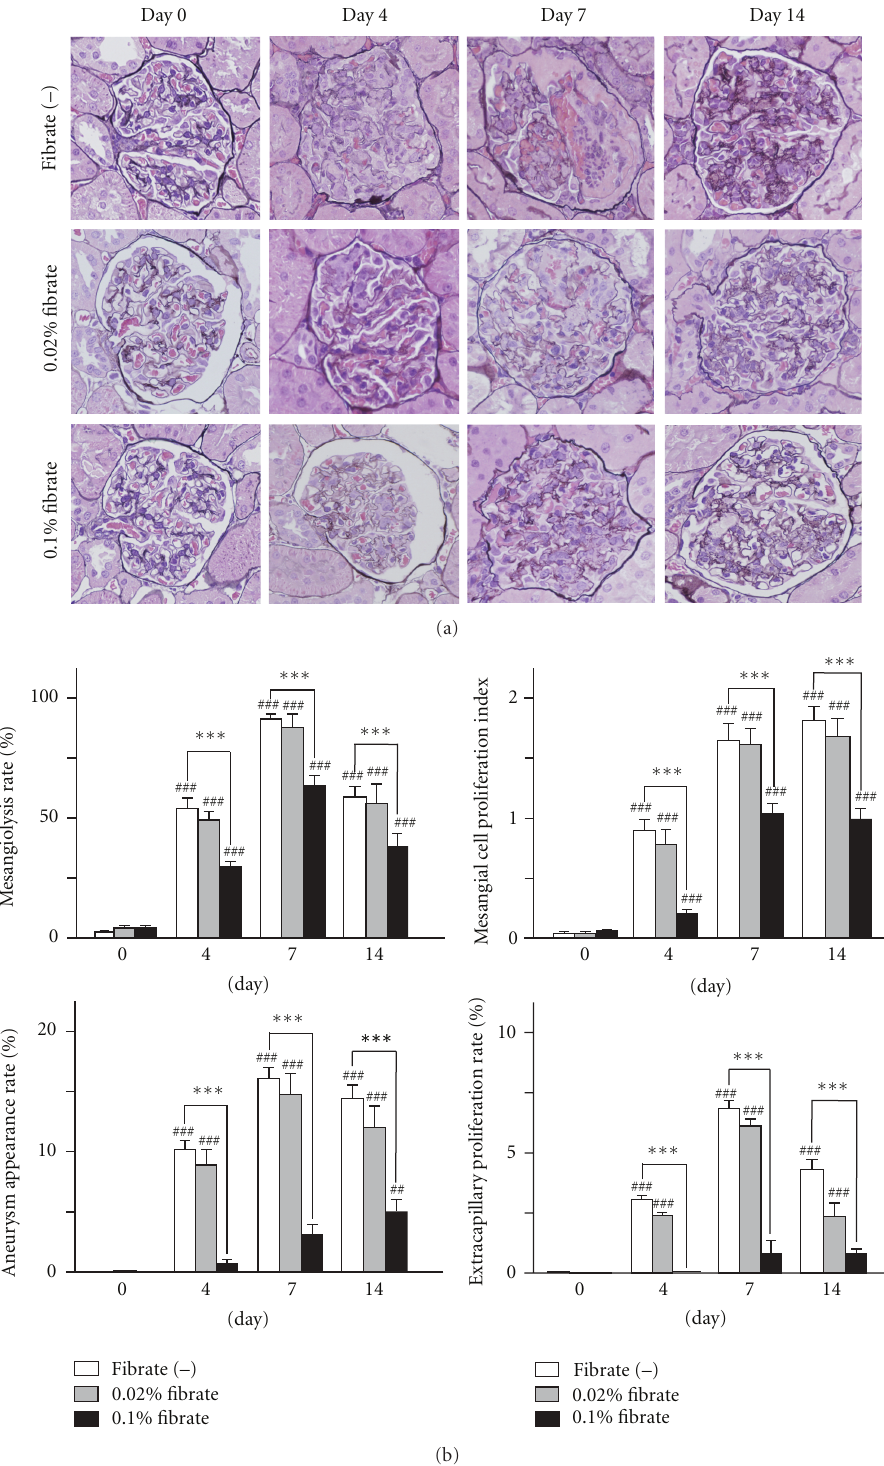
Figure 2: Light microscopic analyses of kidney injuries. (a) Representative micrographs of the kidney in anti-Thy1 nephritis rats. Kidney sections were stained with periodic acid methenamine silver (PAM). (b) Semiquantification of pathologic changes including mesangial cell proliferation, mesangiolysis, glomerular capillary aneurysm formation, and crescent formation. Values are means ± SD. Significant di ff erences from the respective day 0 groups are indicated with number signs ( ## P < 0 . 01, ### P < 0 . 001), while significant di ff erences between regular-diet and clofibrate-diet groups are indicated with asterisks ( ∗∗∗ P < 0 .